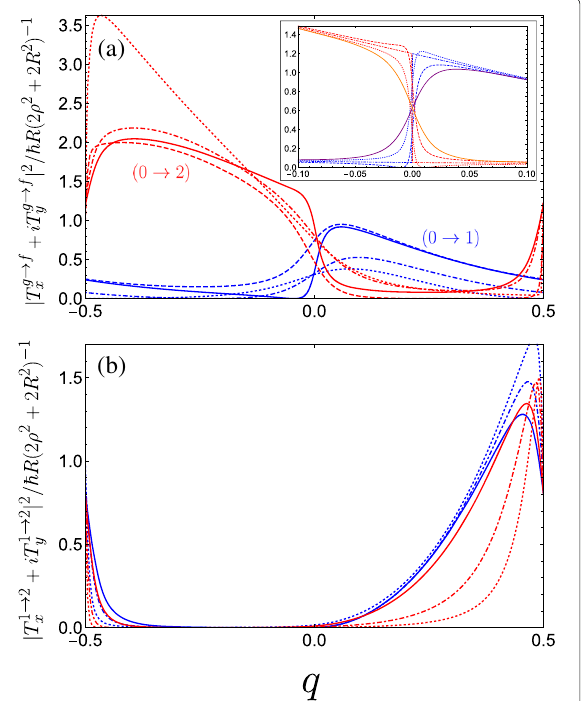
Fig. 6 Square of the dimensionless momentum operator matrix element between the g th and f th subbands in the first Brillouin zone as a function of the dimensionless wave vector q of the electrons photoexcited by right-handed circularly polarized radiation | T x + iT y | 2 and for a variety of parameter combinations spanning the first incident of resonance. a The blue curves denote transitions between the ground and first band while the red curves denote transitions between the ground and second band, both with the following parameters: A g = 0.5 and B g = 0.3 for solid curves, A g = 0.5 and B g = 0.1 for dashed curves, A g = 0.3 and B g = 0.3 for dot-dashed curves, and A g = 0.01 and B g = 0.3 for dotted curves (as A g → 0 the maximum of the 0 → 2 increases rapidly as it approaches q = − 1 / 2). The inset plots the behaviour as B g is tuned through resonance for A g = 0.5; dotted is B g = 0.24, dot-dashed is B g = 0.25, and dashed is B g = 0.26. The solid purple (orange) curve denotes transitions between the ground and first (second) band at resonance with C ⊥ = 0.05 applied. b Plots transitions between the first and second bands. The different blue curves keep A g = 0.5 fixed and vary B g = 0, 0.2, and 0.3 corresponding to dotted, dot-dashed, and solid. The different red curves keep B g = 0.3 fixed while varying A g = 0.05, 0.1, and 0.3 as dotted, dot-dashed, and solid. We have omitted plots for C ⊥ (cid:8)= 0 here as it yields no great qualitative change to the matrix elements axis, given by | T x + iT y | 2 . Notably, we observe a large anisotropy between the two halves of the first Bril- louin zone, while the result for left-handed polarization is a mirror image to what we see in Fig. 6. Physically, this can be attributed to the conversion of the pho- ton angular momenta to the translational motion of the free charge carriers projected onto the direction of the helix axis, with an unequal population of the